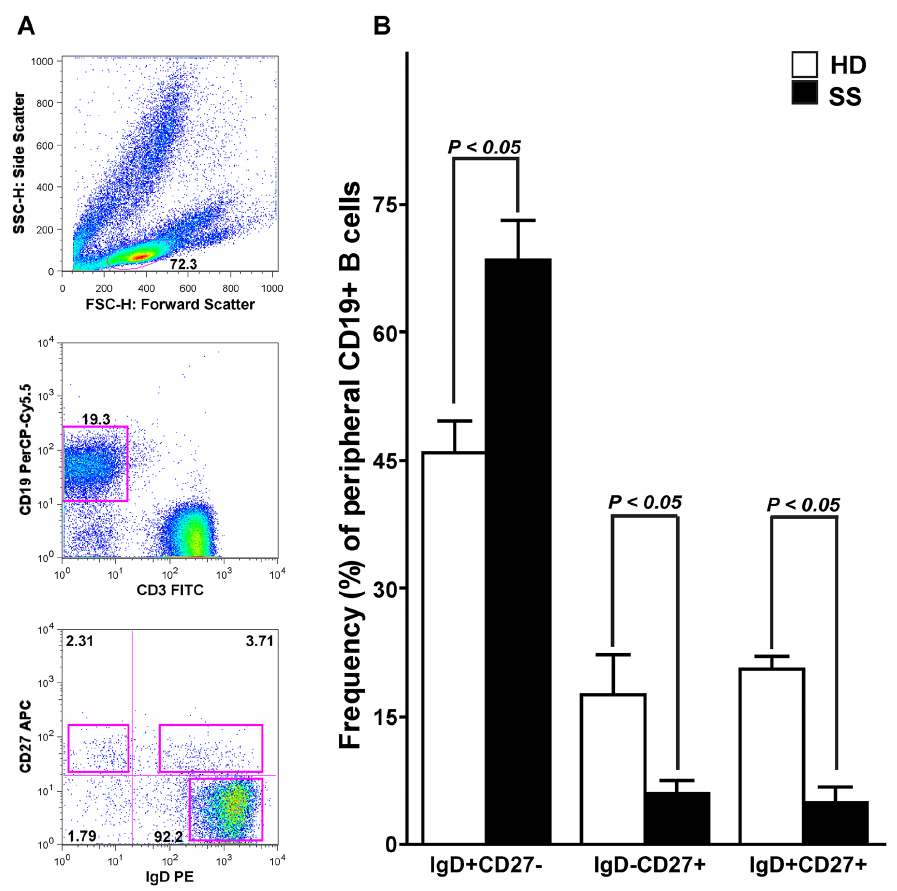
Fig. 1. Isolation strategy of single naı¨ve B cells and comparison of the frequencies of naı¨ve, memory switched and unswitched B cells in SS patients and HD. ( A ) PBMC from SS patients were surface labeled with fluorochrome-coupled anti-CD19, anti-CD3, anti-IgD and anti-CD27. CD19 + CD3 2 cells were gated and analyzed for IgD and CD27 expression. ( B ) The frequencies of peripheral naı¨ve (CD3 2 CD19 + CD27 2 IgD + ), memory switched (CD3 2 CD19 + CD27 + IgD–) and unswitched (CD3 2 CD19 + CD27 + IgD + ) B cells among all CD19 + B cells are shown. Differences between patients and HD were statistically significant using the nonparametric Mann-Whitney U test ( p value is reported over each graph). Error bars indicate standard error of the mean (SEM) for individual patient or